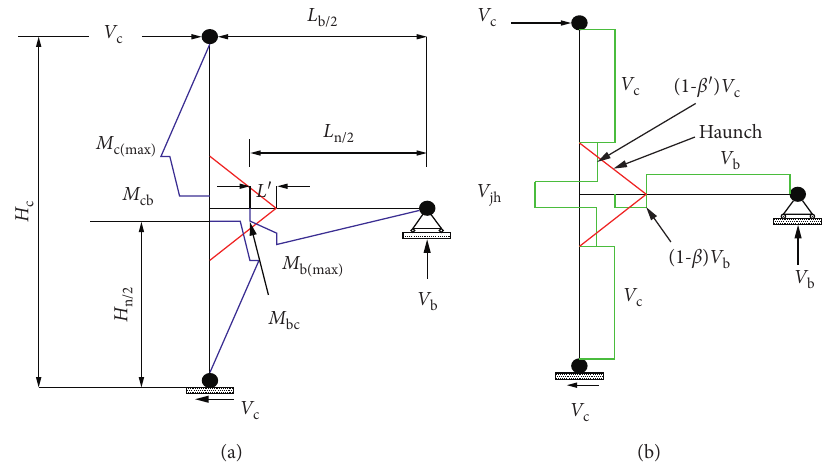
Figure 2: Modified bending moment and shear actions in a haunch retrofitted beam-column sub-assemblages under lateral load. (a) Bending moment diagram. (b) Shear force diagram.